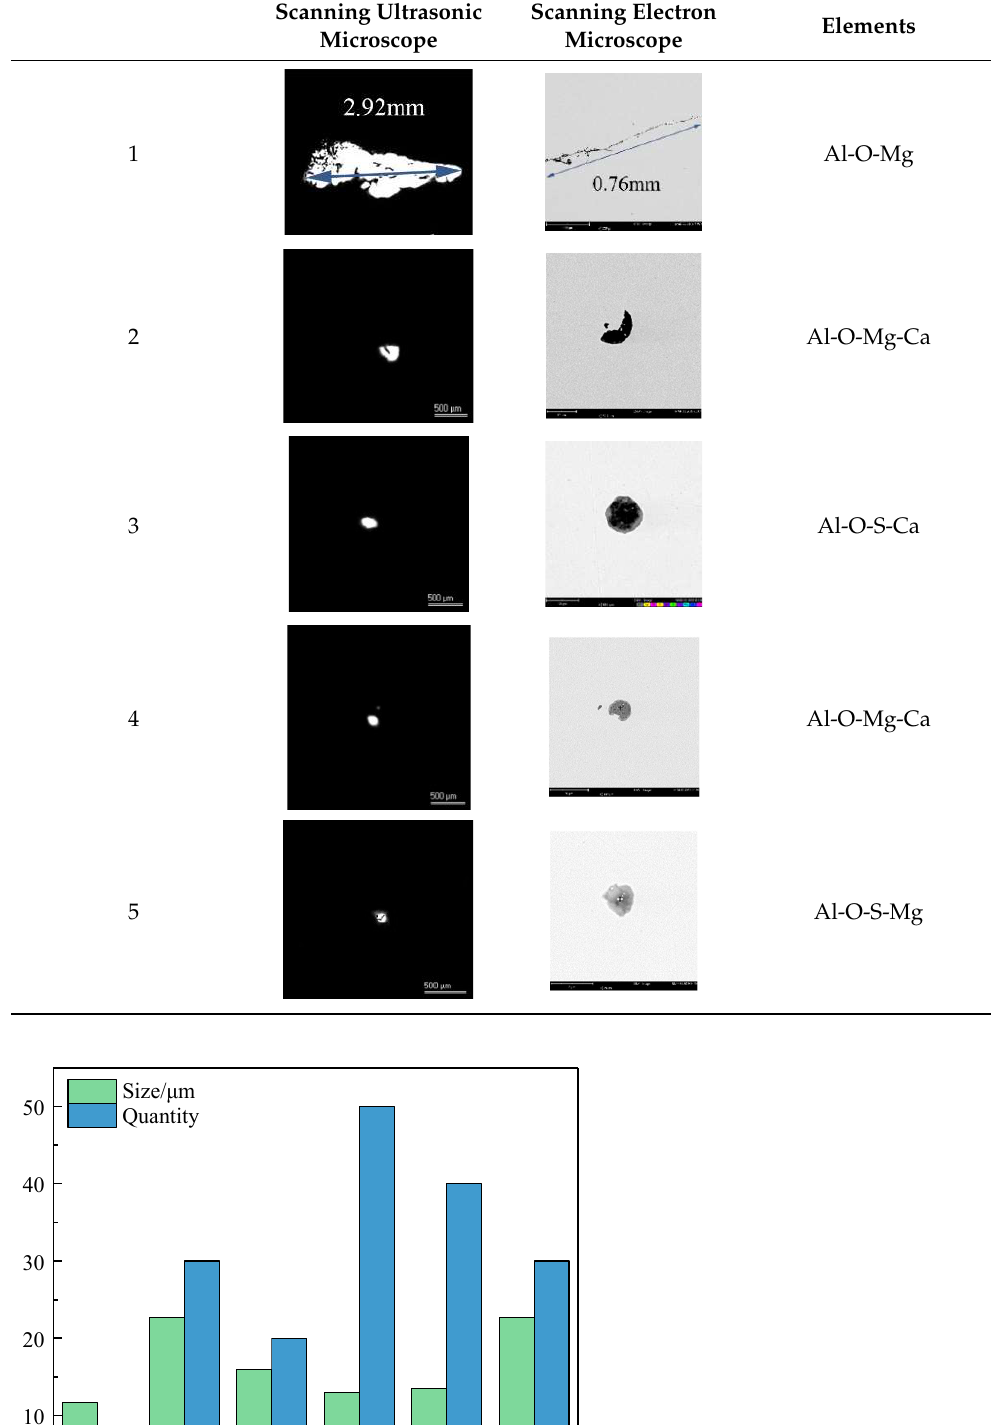
Table 4. Comparison of ultrasonic microscopic scanning and electron microscope scanning images.